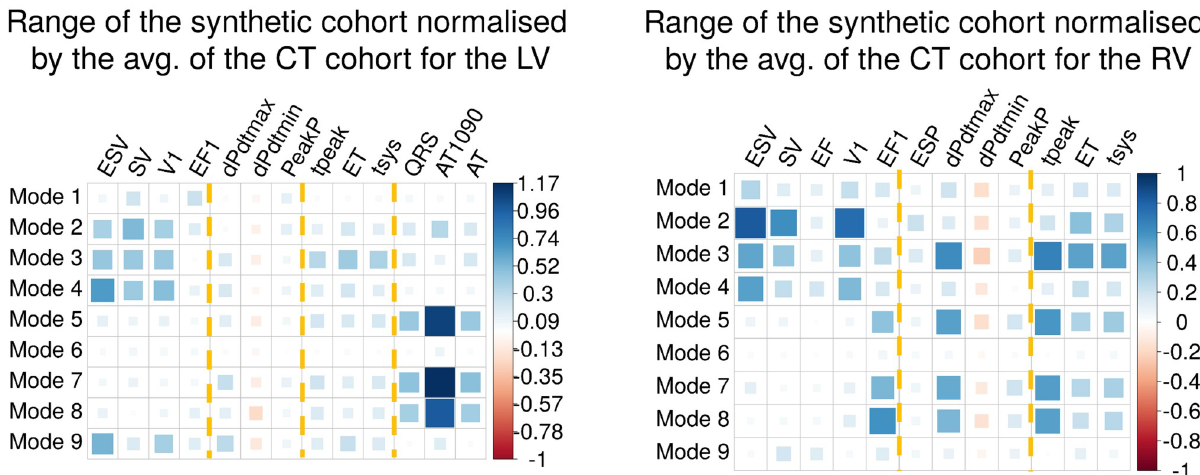
Fig 8. Normalised ranges for the synthetic cohort: For the LV on the left and for the RV on the right. Colour and size indicate the sign and the magnitude of the value. The bigger the value, the more sensitive that phenotype is to changes in that mode. Yellow dotted lines indicate each group of phenotypes: volume-based, pressure-based, time/duration-based and EP-based.